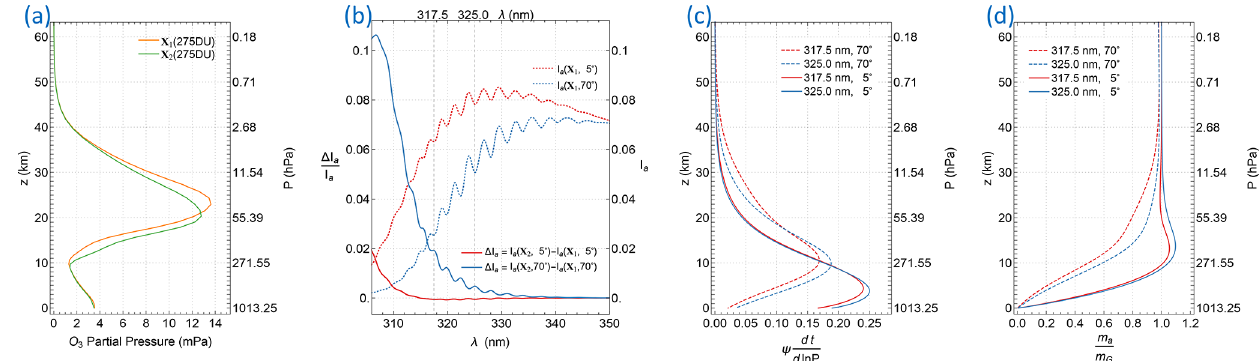
Figure 3. Sample results from RT simulations for a molecular atmosphere with O 3 profiles X 1 and X 2 in panel (a) . Both X 1 and X 2 are midlatitude zone (30 ◦ ≤ latitude ≤ 60 ◦ ) climatological O 3 profiles with the same total vertical column of 275 Dobson units, where 1DU = 2 . 69 × 10 16 molec.cm − 2 . RT simulations are performed for two viewing illumination geometries: (1) low zenith angles of θ s = θ v = 5 ◦ as well as a relative azimuthal angle of (RAA), φ = 45 ◦ and (2) high zenith angles of θ s = θ v = 70 ◦ and φ = 45 ◦ . (b) Path radiances I a ( X 1 ) for the low and high zenith geometries and their fractional changes ( (cid:49)I a /I a ) when the O 3 profile is changed to X 2 . (c) Normalized RCFs, ψ , for EPIC bands 1 and 2. Here ψ(t) is converted into ψ( lnP ) by the multiplication of factor d t/ dlnP. (d) Mean photon path lengths ( m a ) of EPIC bands 1 and 2 as functions of altitude z for the low and high zenith geometries normalized by the respective geometric air mass factors, m G